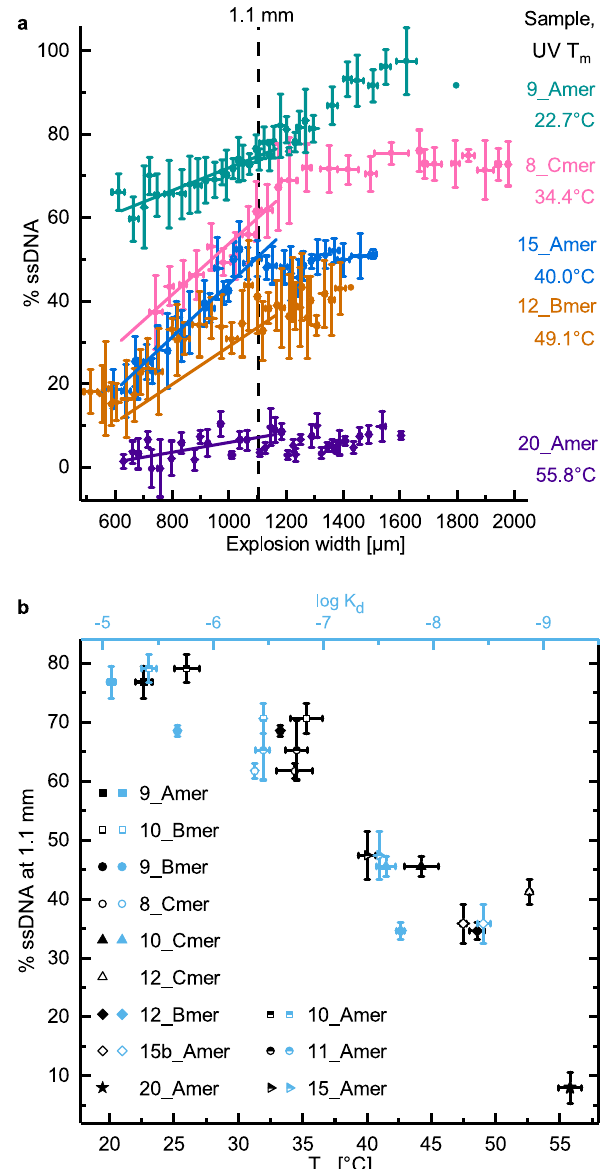
at the explosion width with the best spectral signal-to-noise (1.1 mm). The dotted line indicates this point; at this explosion width % ssDNA serves as a measure of binding affinity. For the sake of legibility, one laser dissociation curve is shown for each of five dsDNA samples. For information on calculations for this figure, see Supplementary Fig. S10. ( b ) Results from LILBID laser dissociation curves from 12 dsDNA samples. % ssDNA at 1.1 mm vs. solution state melting temperature (black) and vs. solution state log K d (blue). All values are shown as mean ± s.e.m., calculated from five LILBID replicates, two to four melting curves and two to five ITC curves per sample. For information on calculations for this figure, see Supplementary Fig. S10. For UV melting curves and representative ITC curves, see Supplementary Figs. S2, S3, S4 and S5. This figure was prepared in OriginPro 2017 (https ://www.origi